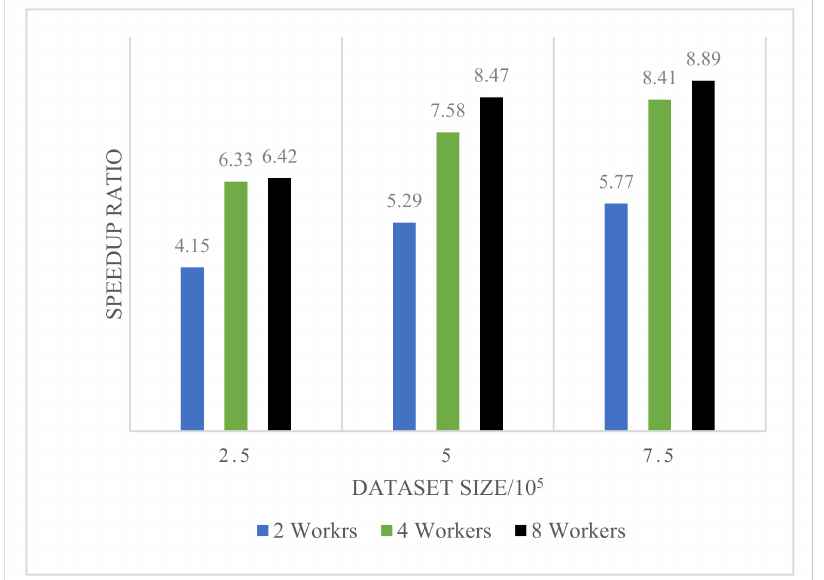
Figure 7. Algorithm speedup for different dataset